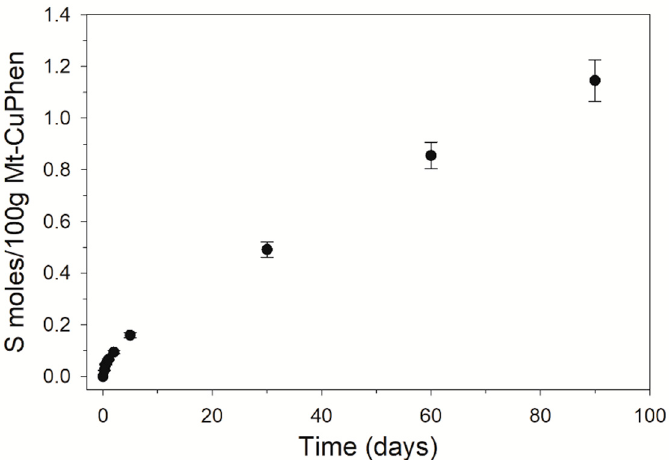
Figure 1. Plot of S content from H 2 S (the S content due to sulfate anions in the starting Mt-CuPhen was subtracted) in Mt-CuPhen as a function of the time of exposure to H 2 S. Error bars indicate the variability of each